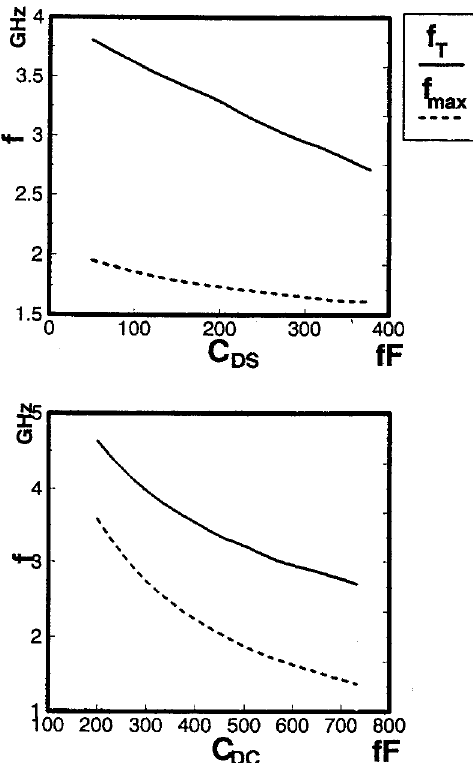
FIGURE 12 The dependence of C DC , C DS on frequency characteristics.